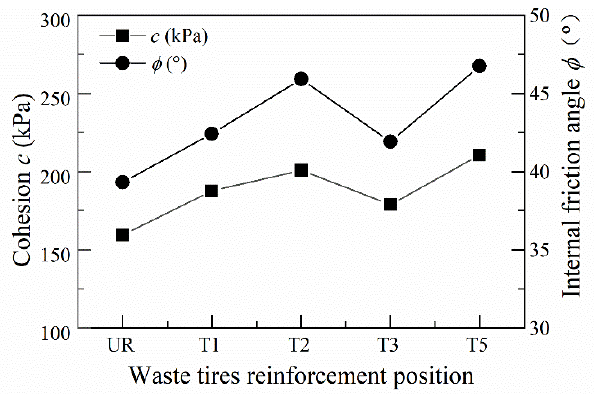
Figure 10. Effect of geogrid reinforcement position on shear strength.